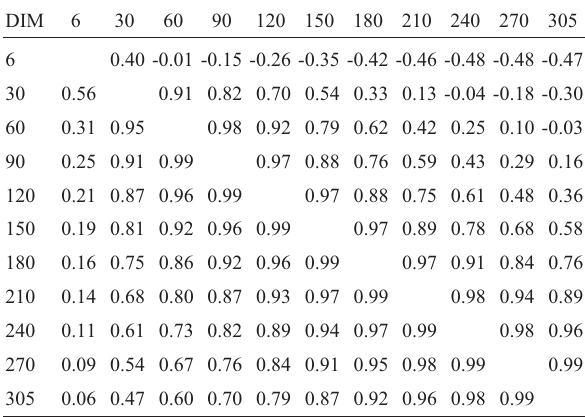
Table 8 - Genetic correlation estimates between selected DIM of daily yields obtained by the RRM1 (above the diagonal) and RRM2 (below the diagonal) models.